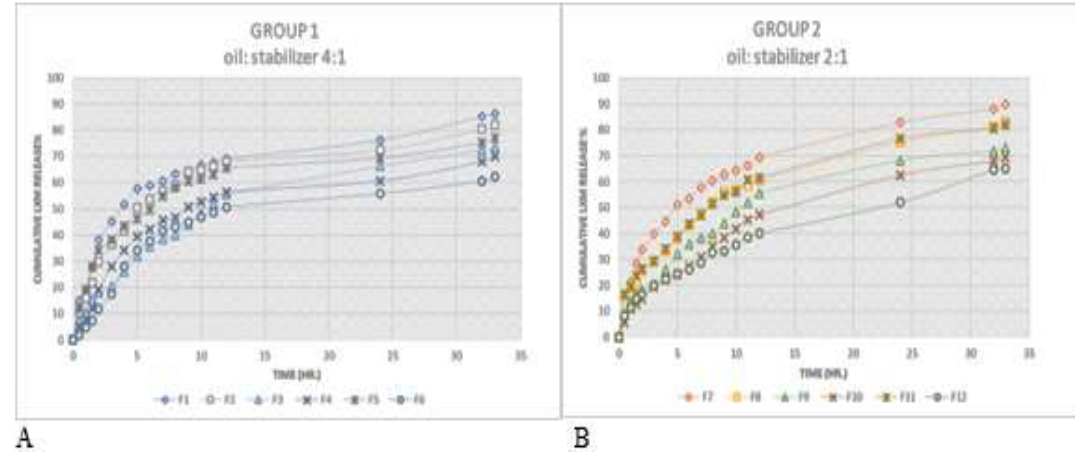
Figure 1.In-vitro release profile of LXM-loaded cubosomal dispersions (F1-F12), divided into two (oil: stabilizer) groups, in phosphate buffer solution pH 7.4 at 32